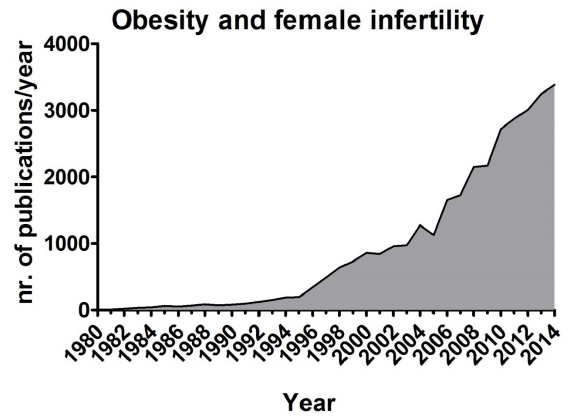
Figure 1. Number of publications reporting the association between female infertility and obesity. The great increase in number of reports appeared per year since 1980 reveals that the interest in the topic has increased during the last decades. Data were obtained using WOS (Web of Science).